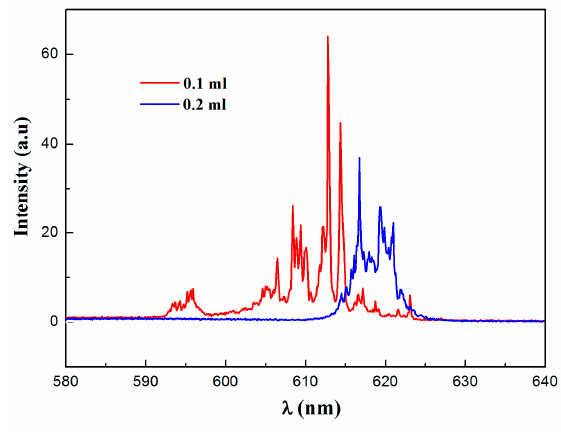
Figure 4. Emission spectra at 0.1 and 0.2 mL MnCl 2 dosage concentration in PM597-doped PDLC with MnCl 2 system at same pump energy 7.65 μ J.